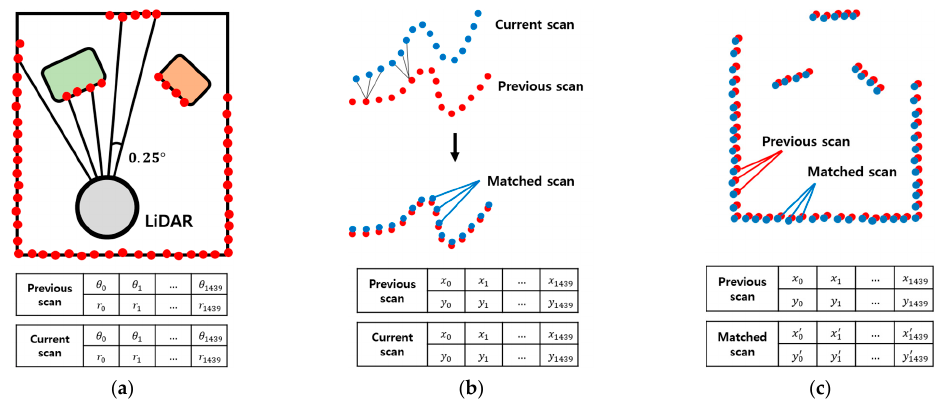
Figure 5. Dynamic objects and scan occlusions in raw scan data. The positions of objects and the occlusions of scans are changed over time. ( a ) t (cid:3404) 𝑡 (cid:2869) ; ( b ) t (cid:3404) 𝑡 (cid:2870) ; ( c ) t (cid:3404) 𝑡 (cid:2871) ; ( d ) t (cid:3404) 𝑡 (cid:2872) .